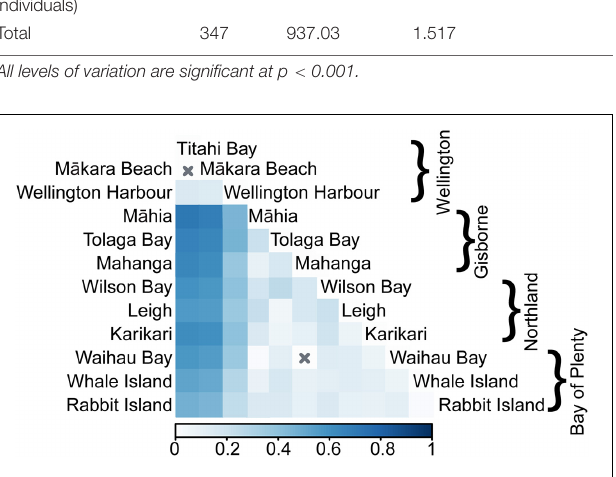
FIGURE 2 | Pairwise genetic differentiation (F ST ) between each site (F ST values indicated by color gradient) with X indicating that sites are not significantly